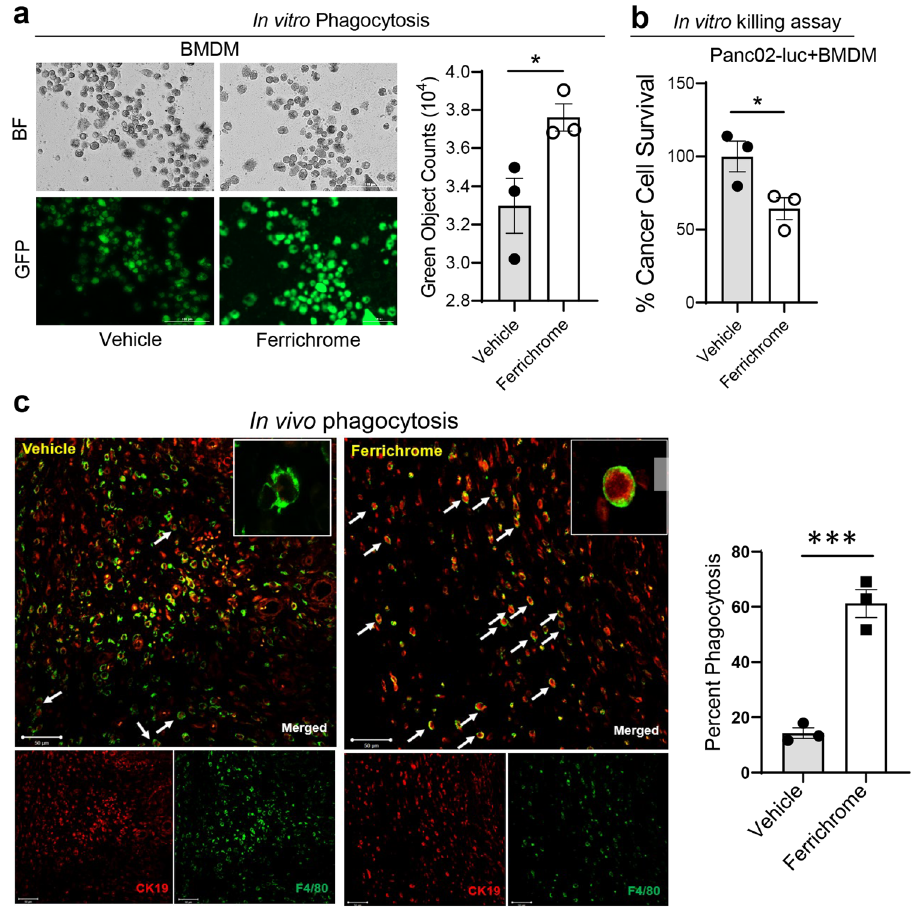
Fig. 3 Ferrichrome promotes phagocytosis and cancer cell killing capacity in macrophages in vitro and in vivo. a Representative image and quanti fi cation of phagocytosis of fl uorescent E. coli bioparticles by BMDMs with the presence of ferrichrome (20 µ M) or vehicle (control) as evaluated by fl uorescent microscopy imaging on the FITC channel ( n = 3 experiments). b Antitumor activity of BMDMs against luciferase-expressing pancreatic cancer cells Panc02 in the presence of ferrichrome or vehicle control. Cancer cells were co-cultured with BMDMs at a macrophage: cancer cell density of 1:1 for 48 h. Tumor cell survival was determined by normalizing luminescence to tumor-only controls ( n = 3). c Representative images of evidence of phagocytosis of cancer cells by macrophages in ferrichrome-treated tumors (right panel) or vehicle-treated tumors (left panel). Images were quanti fi ed using ImageJ software. A phagocytic event is de fi ned by the presence of cancer cell marker Cytokeratin 19 (CK19) (red) within the macrophage markers F4/80 (green) as evaluated by dual-immuno fl uorescence analysis ( n = 4 mice). Bar on micrographs indicates 50 µ m. Mean ± SEM shown. * p < 0.05, and *** p < 0.001 as determined by Student ’ s t